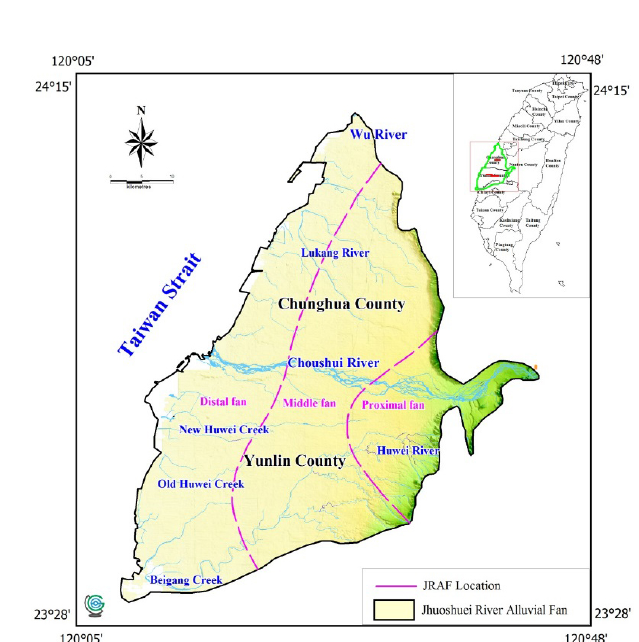
Figure 2. Geological settings of Choshui River Alluvial Fan (modified from Central Geological Survey of Taiwan, http://www.